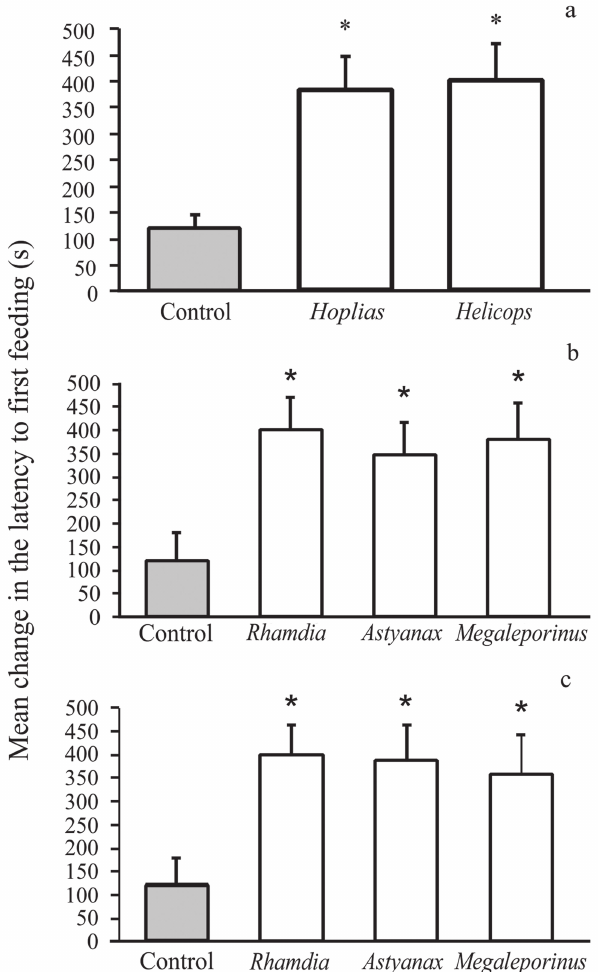
Fig. 3. Mean (± SE) change in Latency to first feeding (s) of juvenile catfish after exposure to a. odor of predators Hoplias malabaricus and Helicops infrataeniatus ; b. odor and c. skin extract of conspecifics and non-predators Astyanax lacustris and Megaleporinus obtusidens . Solid bars = control; Open bars = disturbance treatment. *indicates a significant difference when compared to control (p <